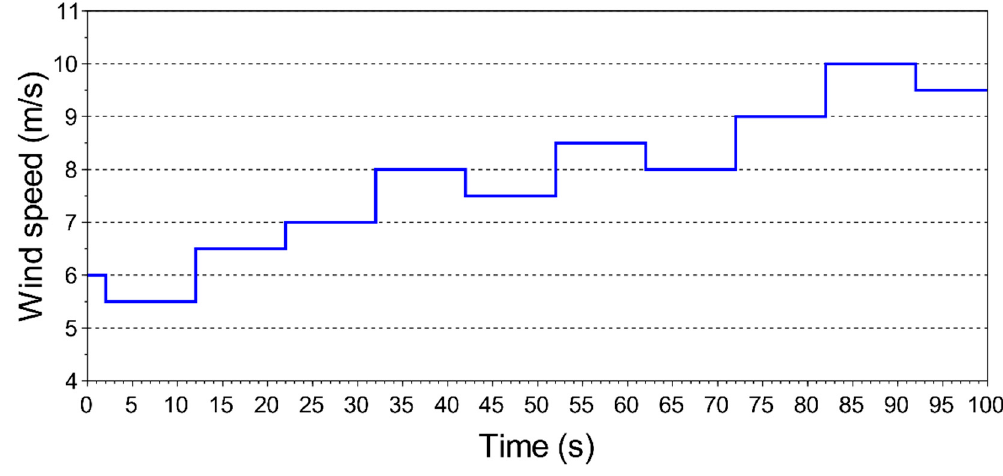
Energies 2020 , 13 , 770